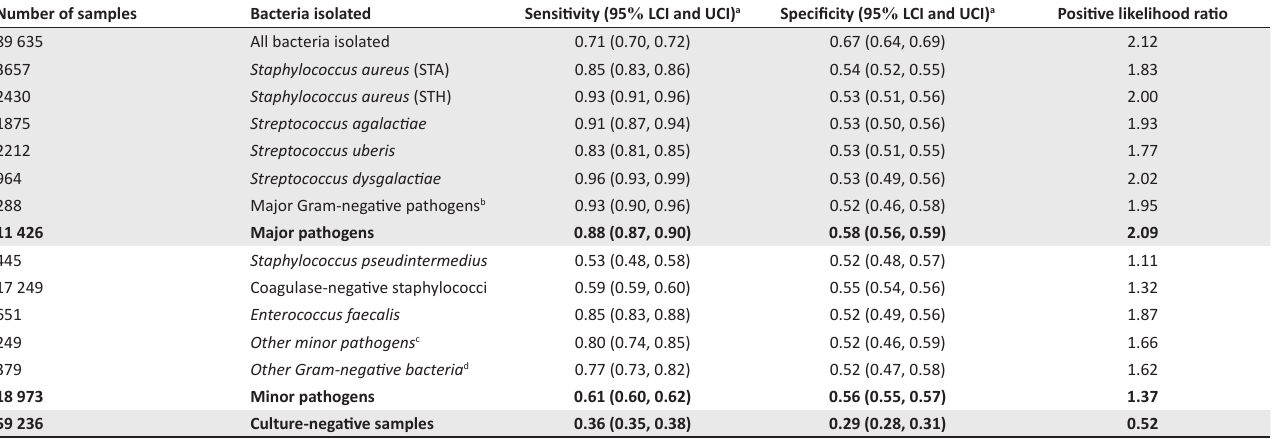
TABLE 3: Sensitivity and specificity with 95 % confidence intervals for pathogen-specific detection using somatic cell counts threshold of 200 000 cells/mL milk in quarter milk samples and positive likelihood ratios at somatic cell counts thresholds of 200 000 cells/mL. Number of samples Bacteria isolated